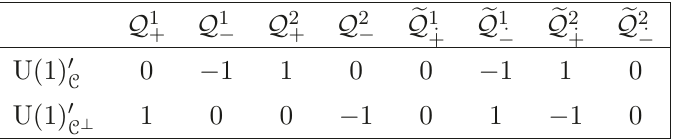
Table 2 . Donaldson-Witten